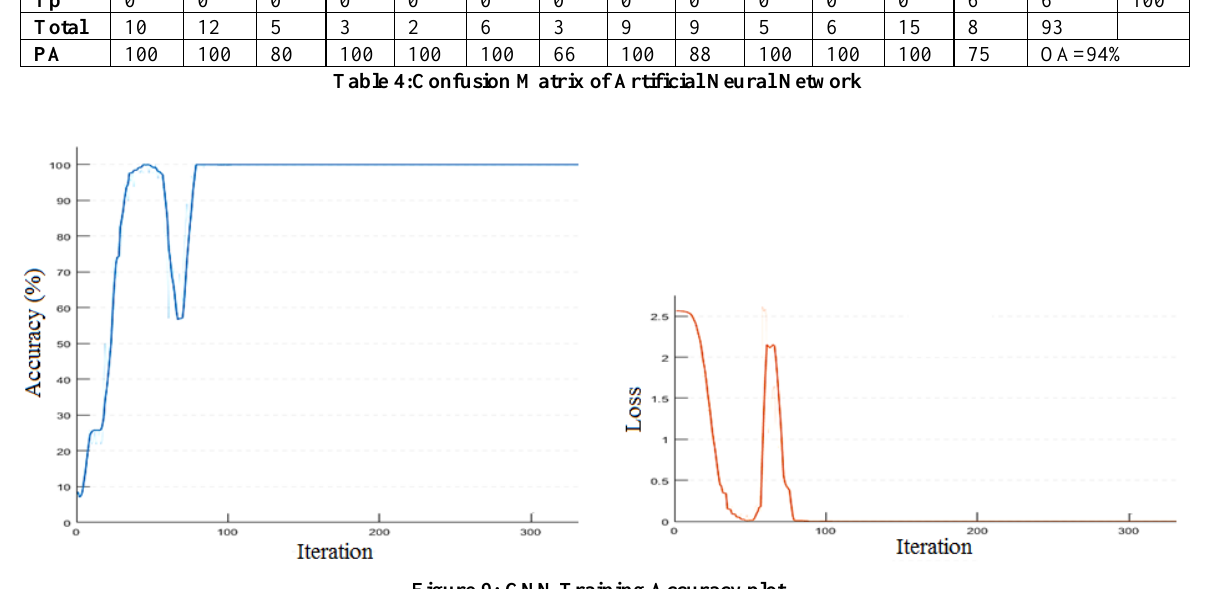
Figure 9: CNN Training Accuracy plot